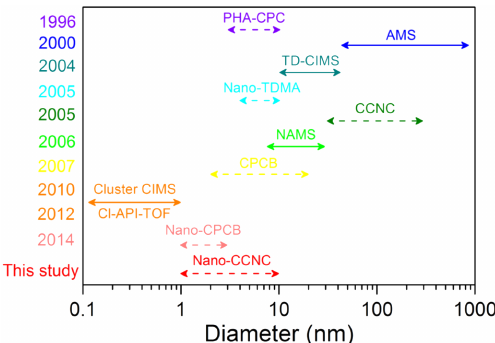
Figure 1. Direct and indirect methods for measurement/estimation of atmospheric aerosol chemical composition (modified from Kul- mala et al., 2012). The year when each technique was first reported is indicated on the left-hand side. The solid arrowheads indicate the direct measurements, whereas dashed arrowheads represent the indirect measurements. The use of scanning supersaturation CPC (SS-CPC) as nano-CCNC introduced in this study mainly focus on the size range of 1–10nm.